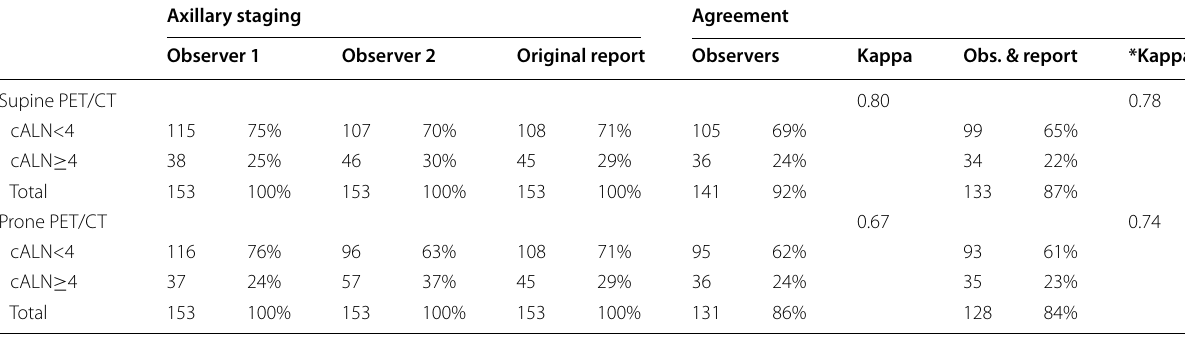
Data are N , %.*Fleiss kappa. Original report staging at time of treatment including both supine and prone FDG-PET/CT